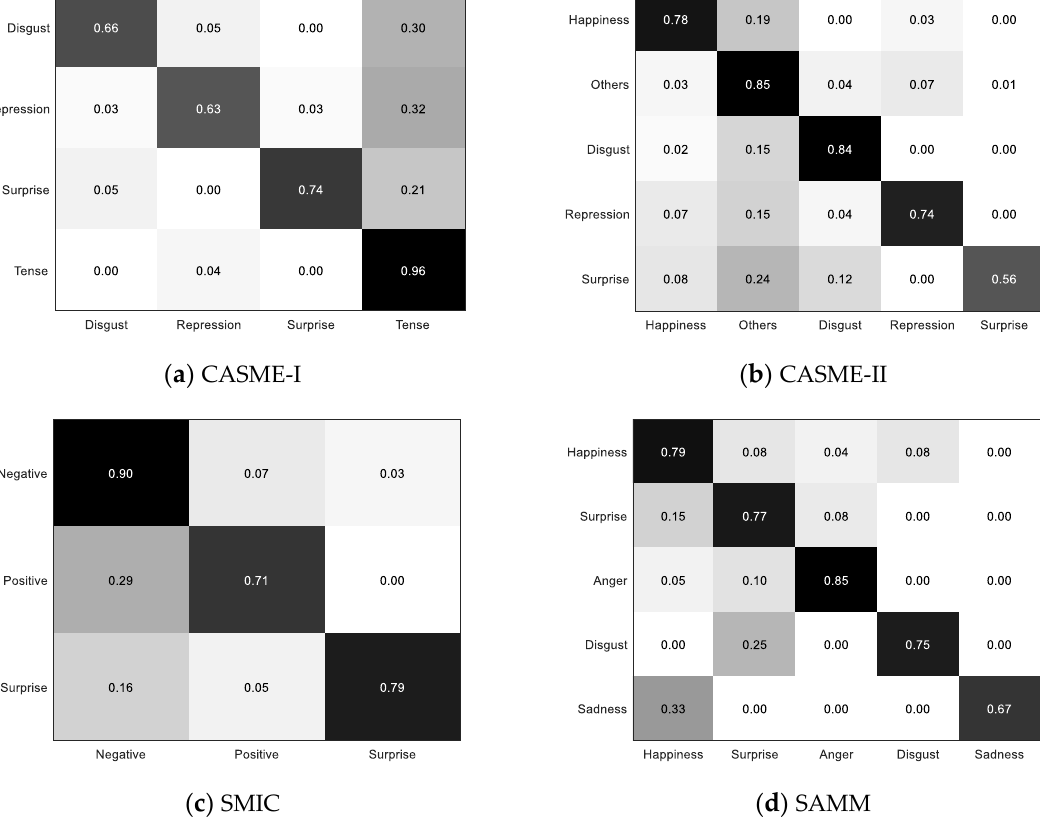
Figure 9. The confusion matrix is calculated based on the LOSO results of CASME-I, CASME-II, SMIC, and SAMM, respectively.